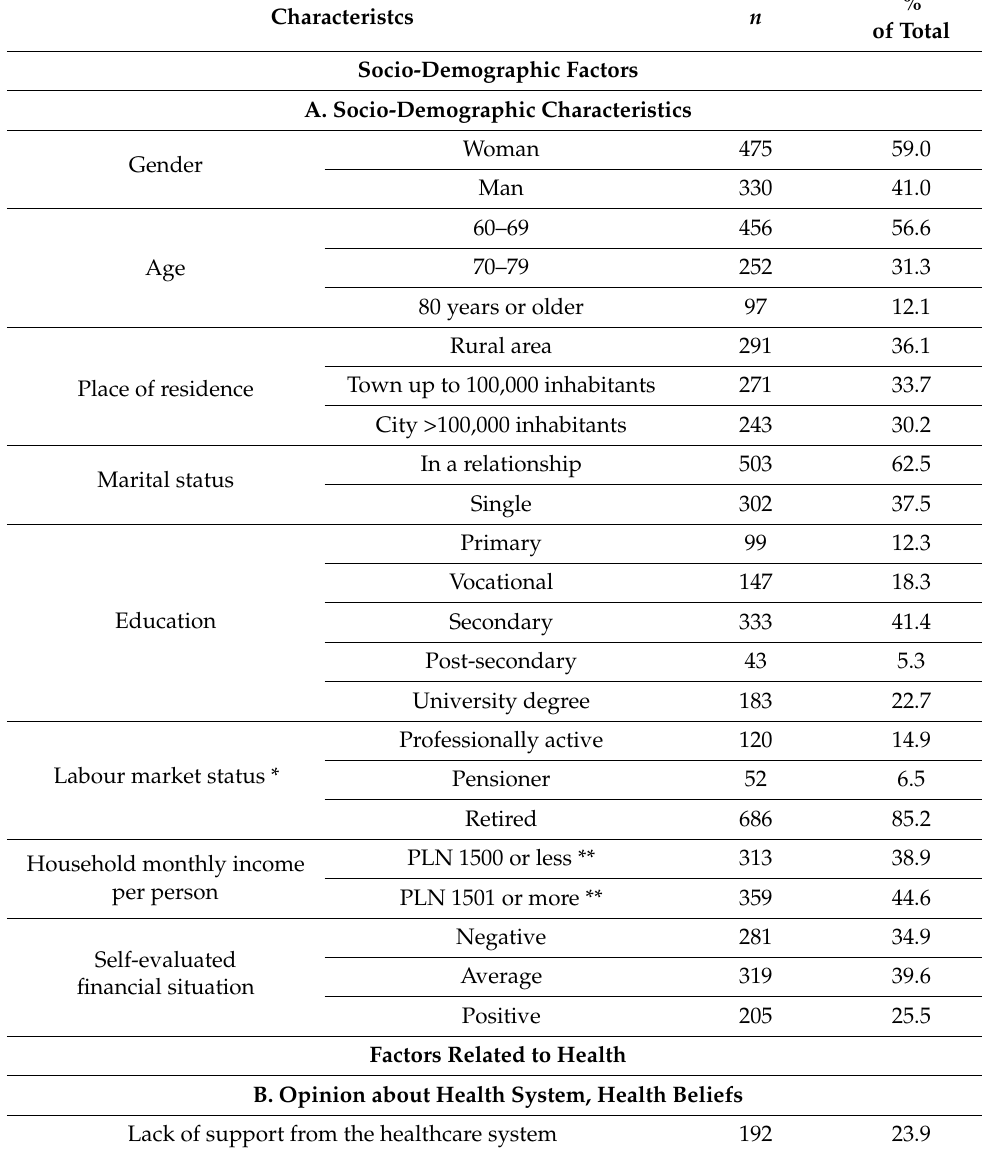
Table 1. The frequency of occurrence for respondents’ selected